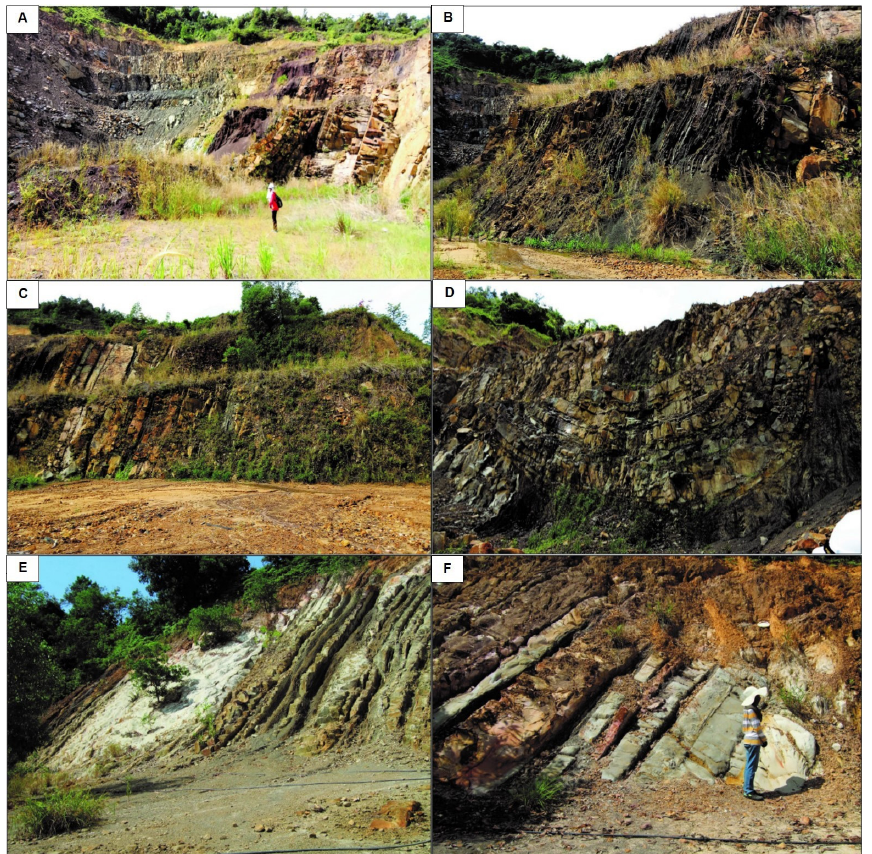
Figure 2. Characteristic examples of lithofacies encountered in the study area. ( a ) Outcrop section showing the sandstone and mudstone with incline bedded at L1. ( b ) Outcrop section showing the thickness of the interbedded sandstone and mudstone at L1. ( c ) Interbedded sandstone and mudstone at L1. ( d ) Syncline structure in the L1. ( e ) Outcrops of interbedded sandstone and mudstone in L2. ( f ) Massive sandstone in L2.